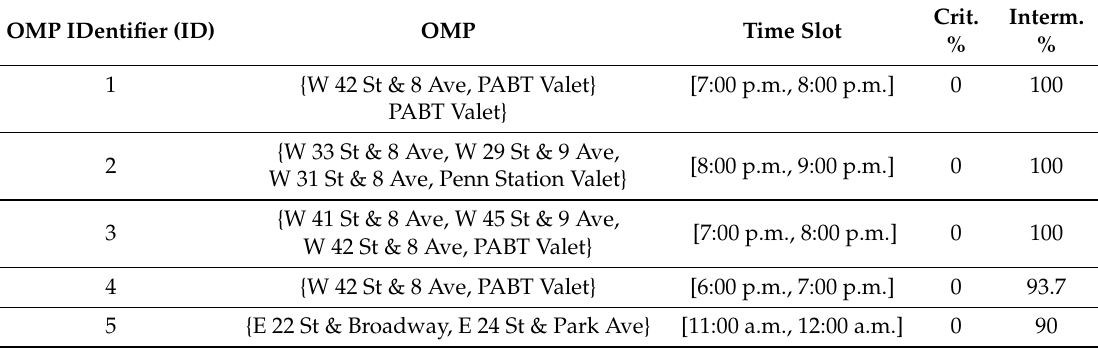
Table 4. Citi Bike (New York). Groups of stations with maximal intermittence in different hourly time